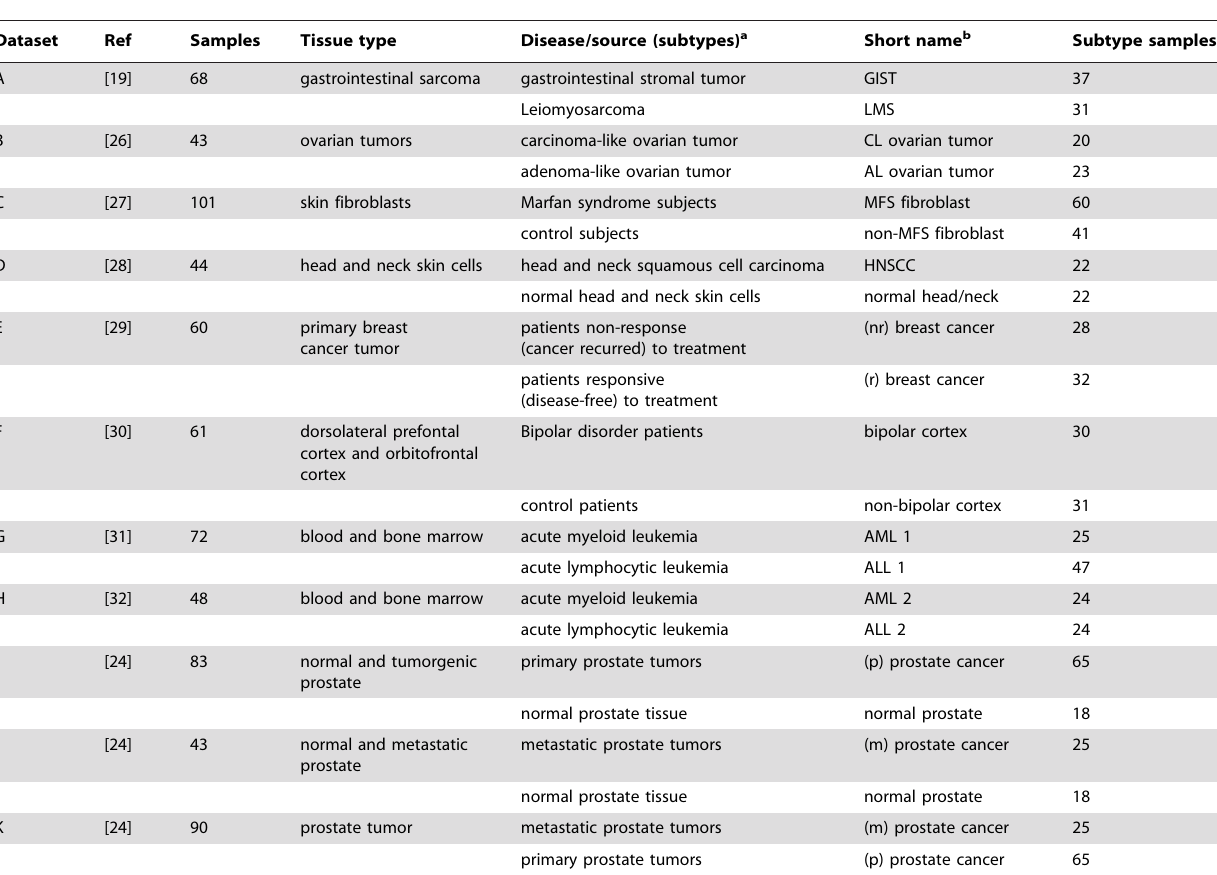
Table 2. Human disease gene expression datasets studied with